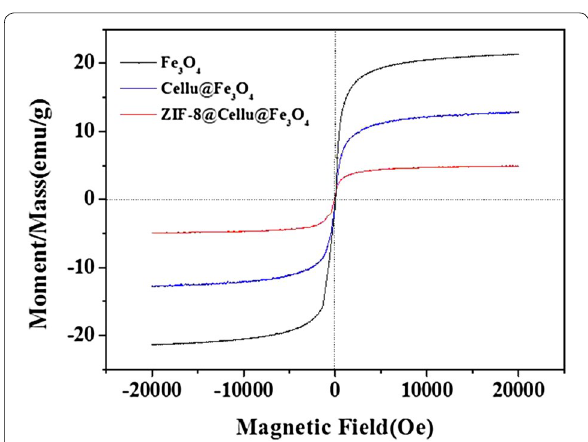
Fig. 4 Hysteresis loops of Fe 3 O 4 , Cellu@Fe 3 O 4 , ZIF‑8@Cellu@Fe 3 O 4 , and GOx‑ZIF‑8@Cellu@Fe 3 O